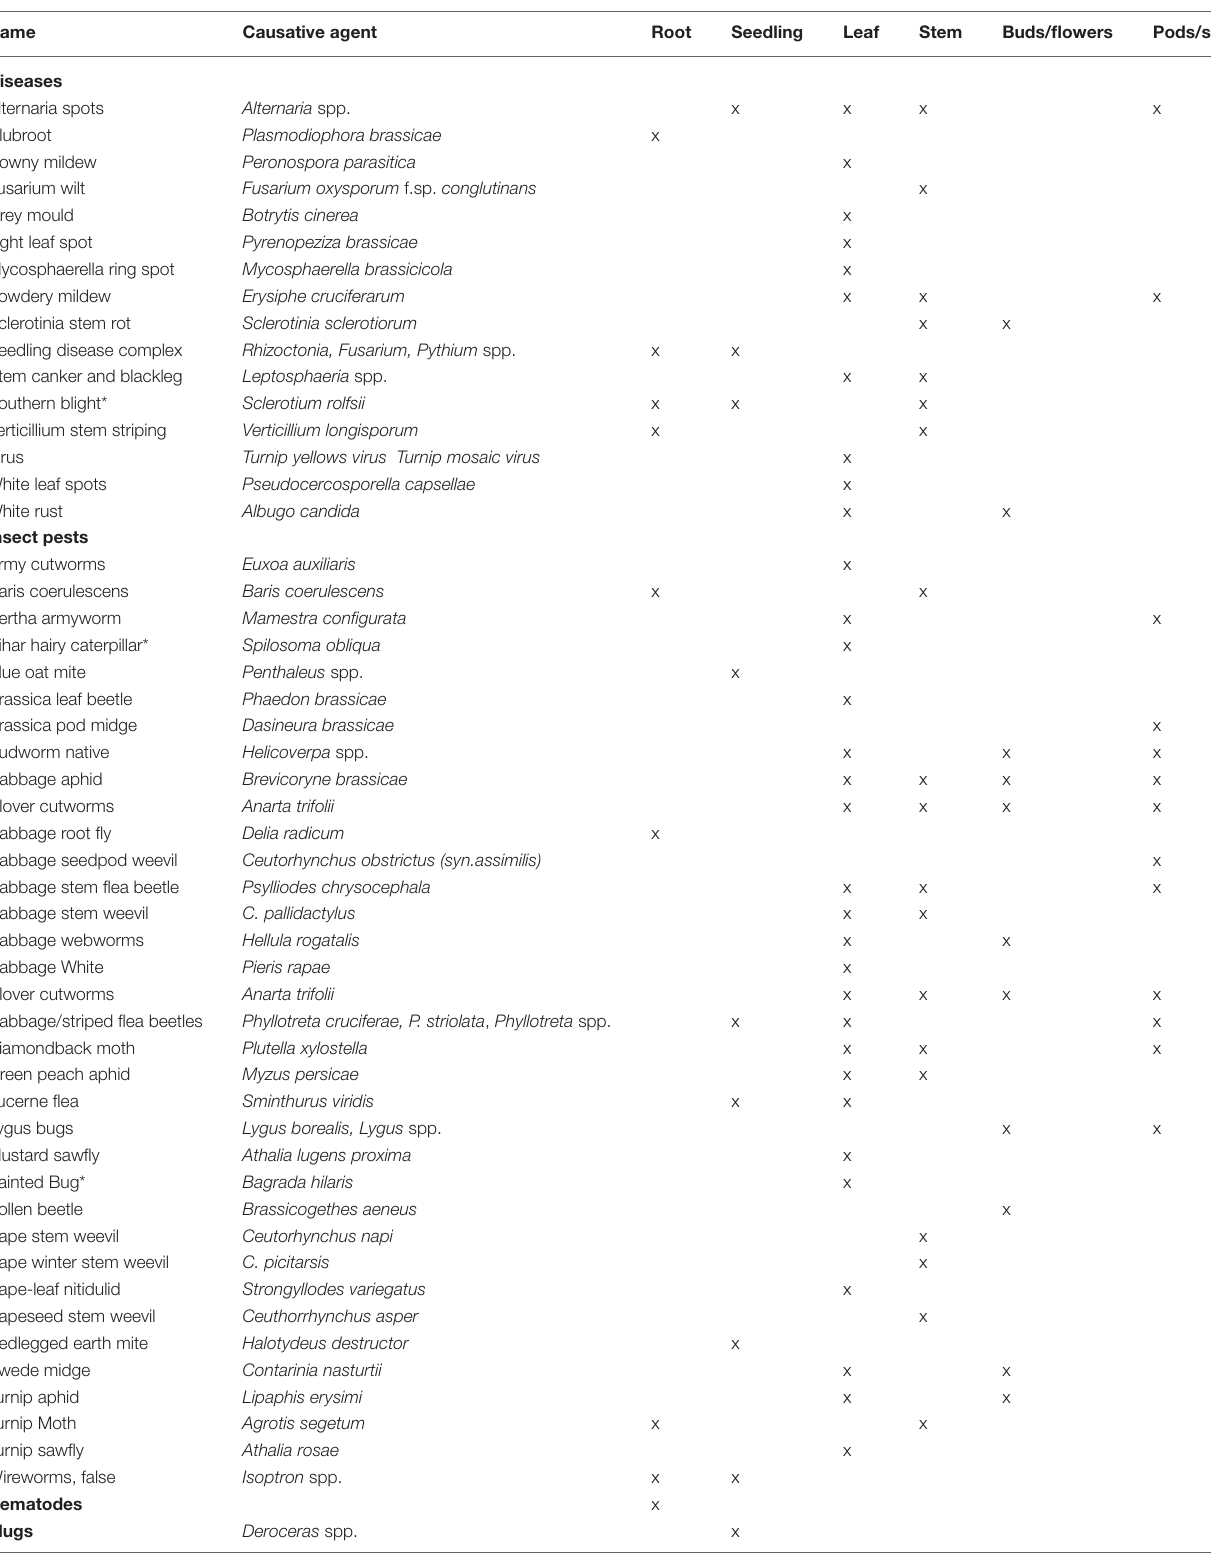
TABLE 1 | Diseases and insect pests on oilseed rape or mustard worldwide and their infection/feeding site on the plants (2016 until present), based on statements by 22 experts from 10 countries.